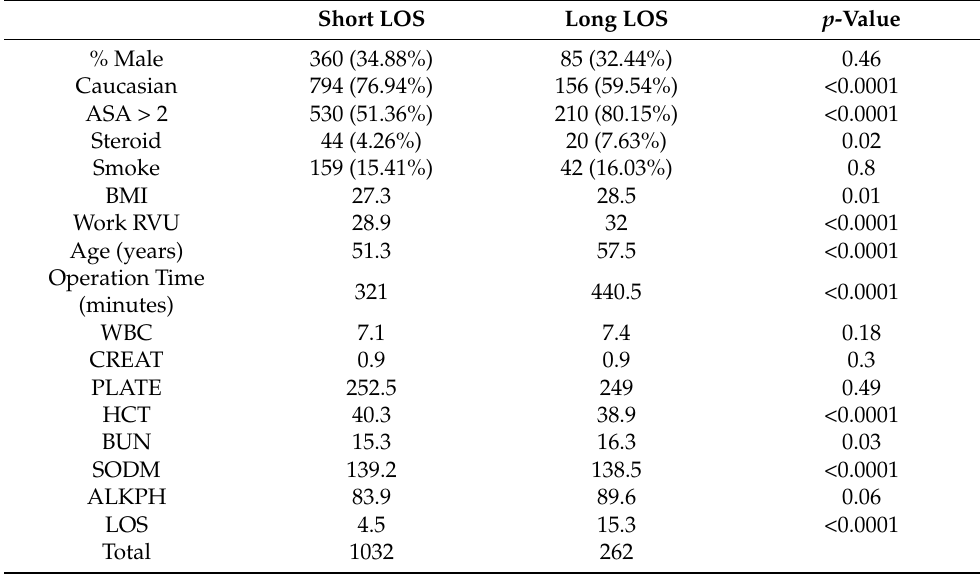
Table 1. A demographics table of patients with short and long LOS for posterior spine fusion cases.